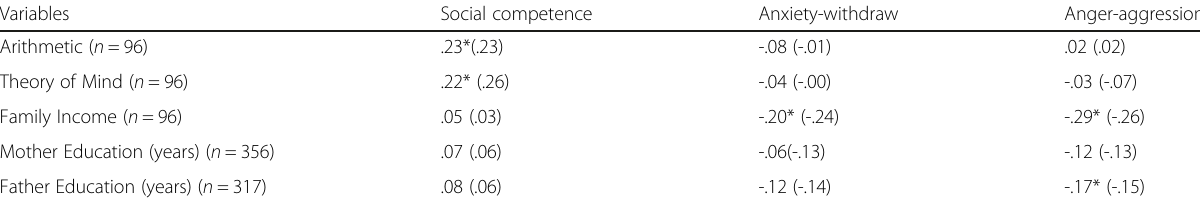
Table 4 Correlations between the SCBE (5-item subscales) and criteria variables